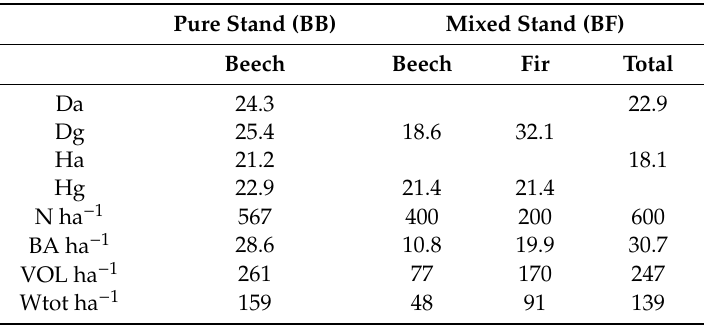
Table 2. Properties of the pure beech stand (BB) and the mixed beech-fir stand BF sites as measured in 2017 (Da: Arithmetically averaged tree diameter at breast height [cm]. Dg: Tree basal area based on average diameter at breast height [cm]. Ha: Arithmetically averaged tree height [m]. Hg: Tree height of Dg [m]. N: Number of trees. BA: Tree basal area in 1.3 m height [m 2 ]. VOL: Total stem volume [m 3 . Wtot: Total woody aboveground biomass (tons)). The data were obtained on plots of 300 m 2 . Hg was calculated with logarithmic best-fit functions based on available height and diameter measurements; VOL and Wtot were estimated from Hg and Dg following Gasparini et al. [34]. Pure Stand